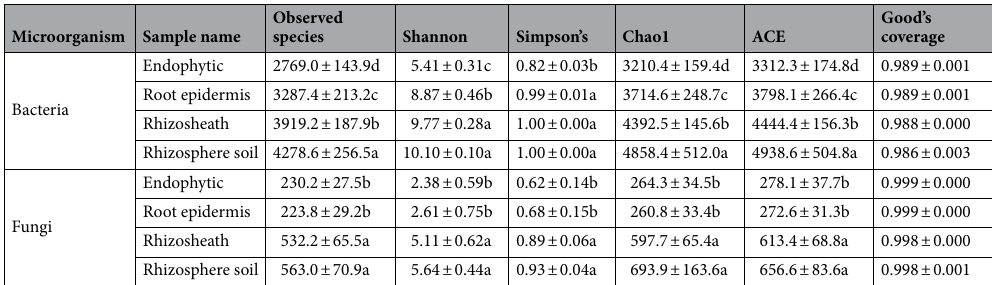
Table 1. Alpha diversity of bacteria and fungi in roots, rhizosheath, rhizosphere soil and non-rhizosphere soil. Different lowercase letters in the same column indicate significant differences between bacterial or fungal groups ( p <